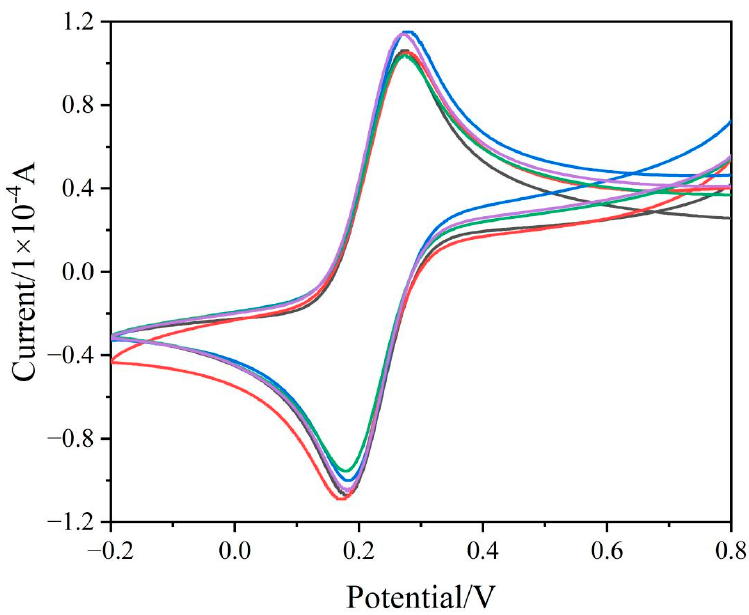
Figure 1. Cyclic voltammetry (CV) curve of the same electrode in 0.1 mol/L KCl containing 5 mmol/L of Fe(CN) 63 − /Fe(CN) 64 − after polishing ( n = 5).